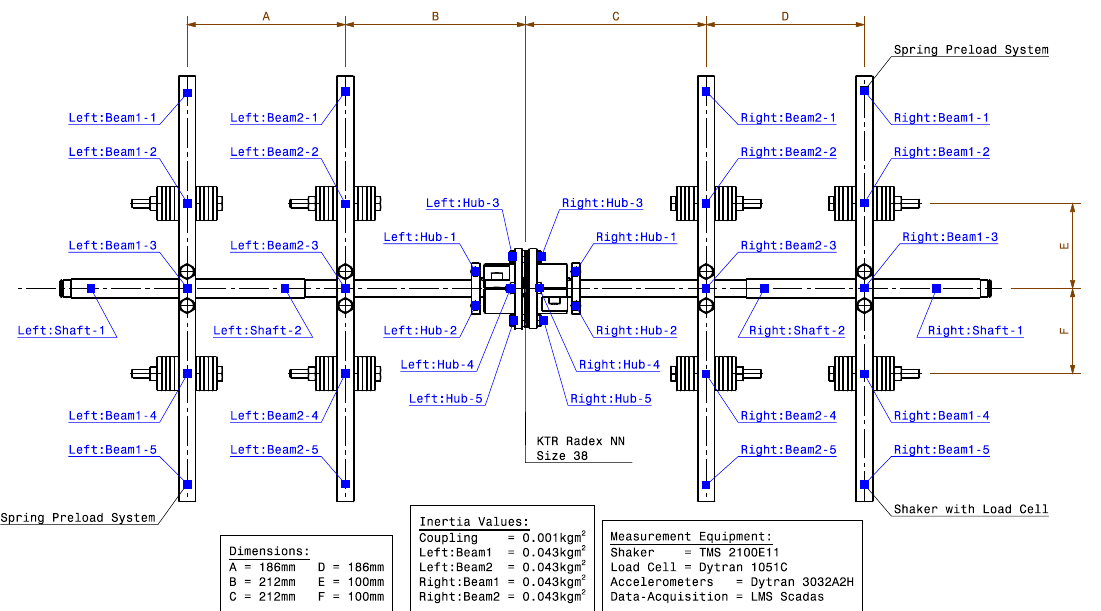
Figure 4. Overview of the test setup with all dimensions, inertia values, sensor locations and used measurement equipment. The exact positions and used nomenclature for the accelerometers are indicated in